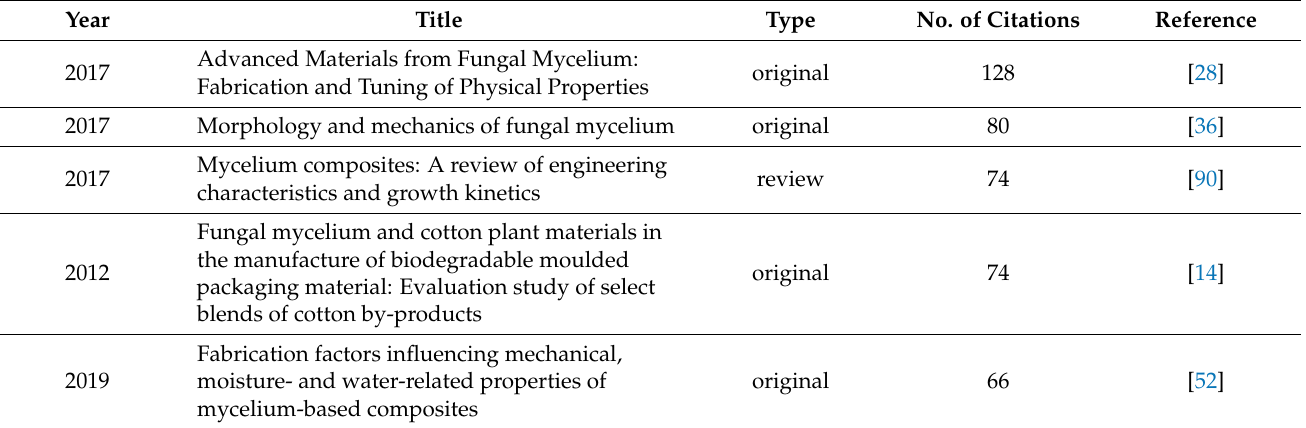
Table 1. The most frequently cited articles on mycelium-based composite materials according to Scopus.